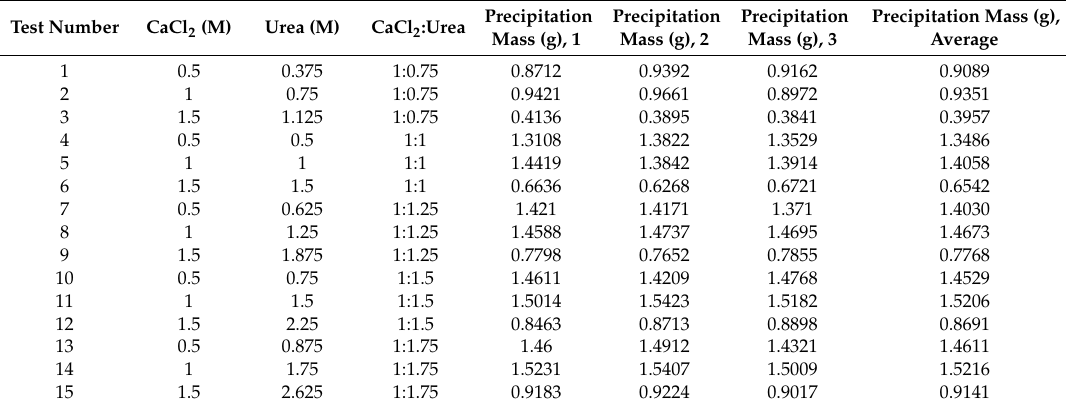
Table 3. Precipitation mass for di ff erent constituent concentrations and